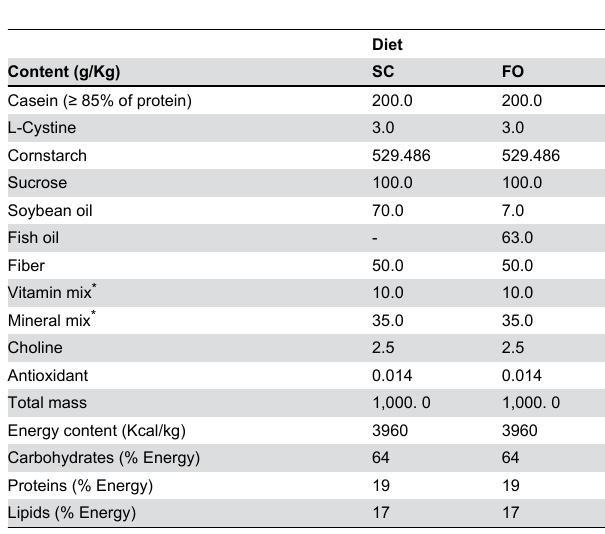
Table 1. Composition and energy content of the standard chow (SC) (AIN 93G) and the fish oil (FO) (AIN 93G-based diet)